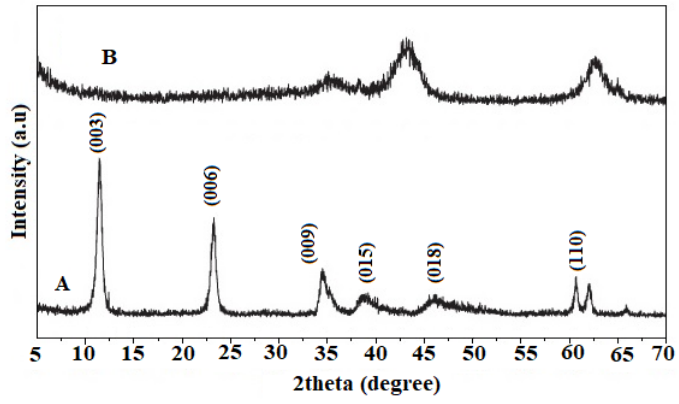
Fig.1. The XRD patterns of Mg-Al LDH (A) and calcined LDH (B).